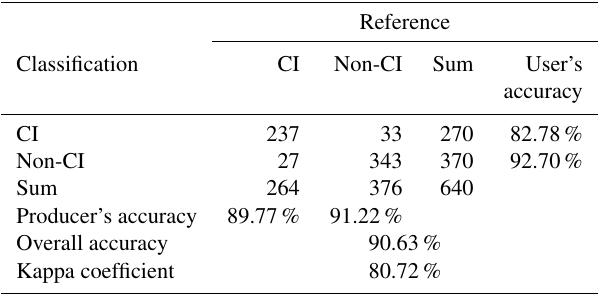
Table 7. Assessment of the LR model for CI detection using the test data set. CI probabilities above 50% considered as a CI.